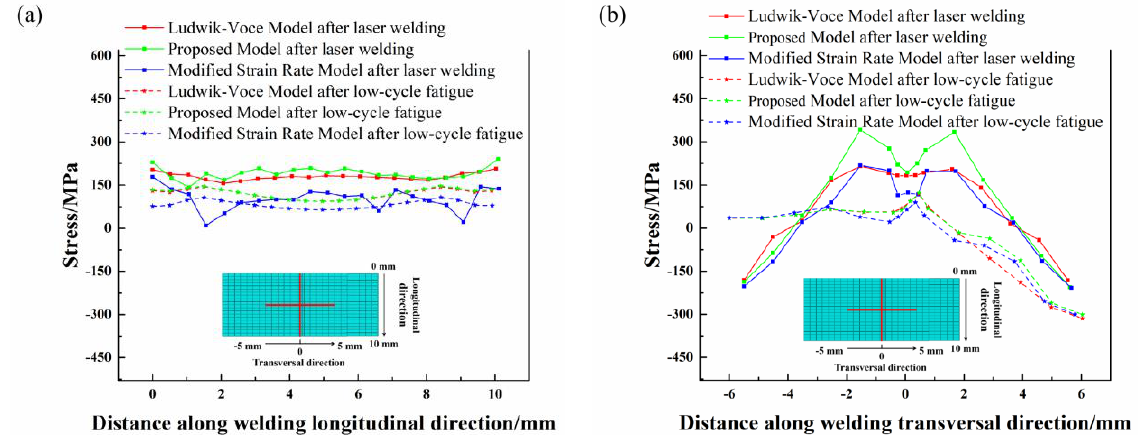
Figure 17. Laser welding and low-cycle fatigue residual stress for ( a ) longitudinal, ( b ) transversal.